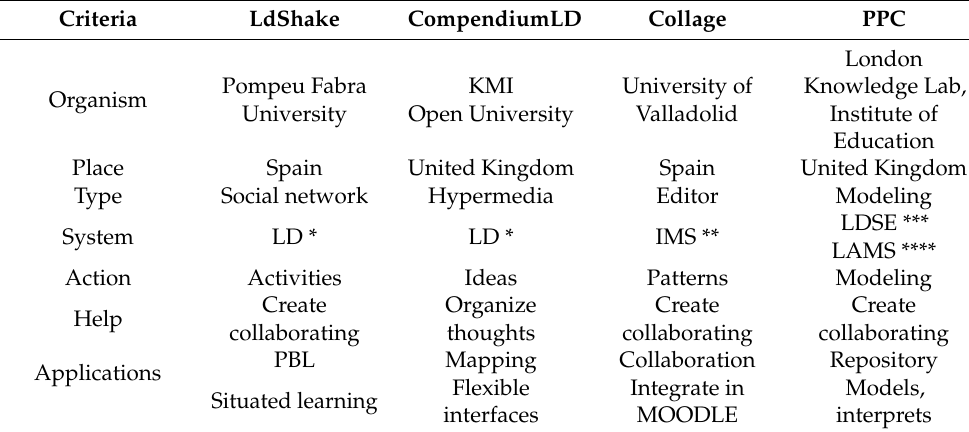
Table 2. Pattern